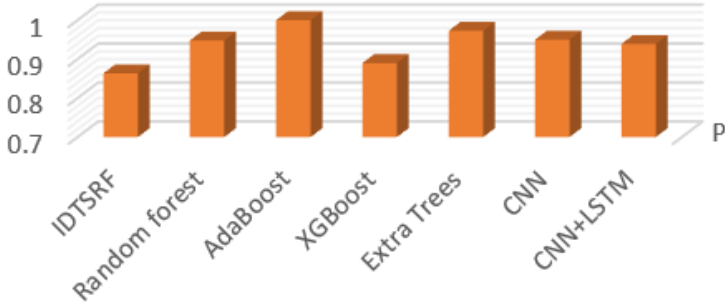
Figure 10. P Comparison chart.